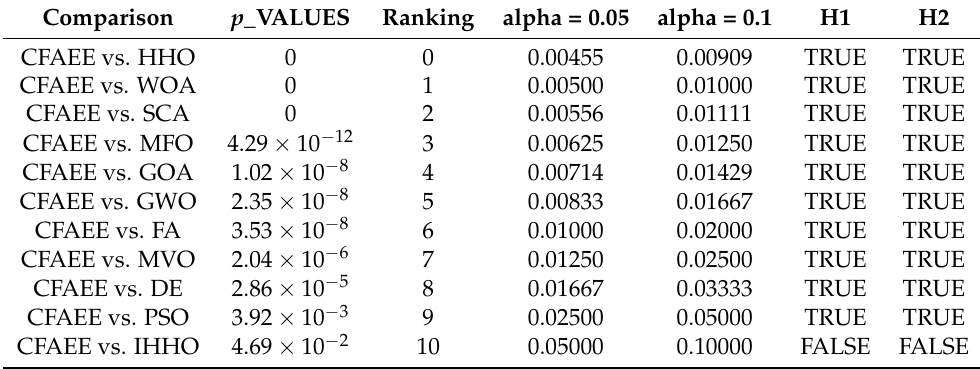
Table 14. Results of the Holm step-down procedure.